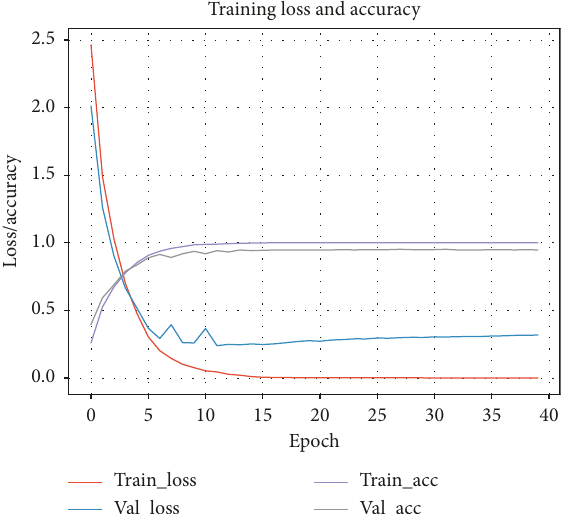
Figure 14: Accuracy and loss during CNN 1 training and validation.